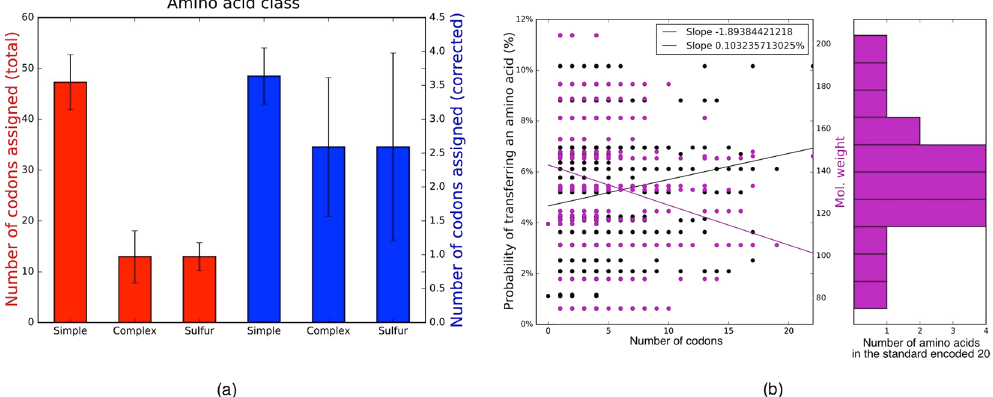
Figure 5. Regularities of the artificial genetic codes. We analysed the average properties of the 50 most optimal artificial genetic codes, one from each of 50 the independent runs. ( a ) Like the standard genetic code, the class of simple amino acids has more assignments than the complex and sulfur classes (red). This may partly result from the fact that the simple class is more frequent among the 20 encoded amino acids, but this tendency remains even if we correct for the unequal distribution of classes (blue). ( b ) Like the standard genetic code, there is a positive correlation between an amino acid’s frequency in proteins, modelled in terms of probability of amino acid transfer, and number of assignments (black). And there is also a negative correlation between its molecular weight and number of assignments (purple). Again, this may partly result from the fact that lighter amino acids are more frequent among the 20 encoded amino